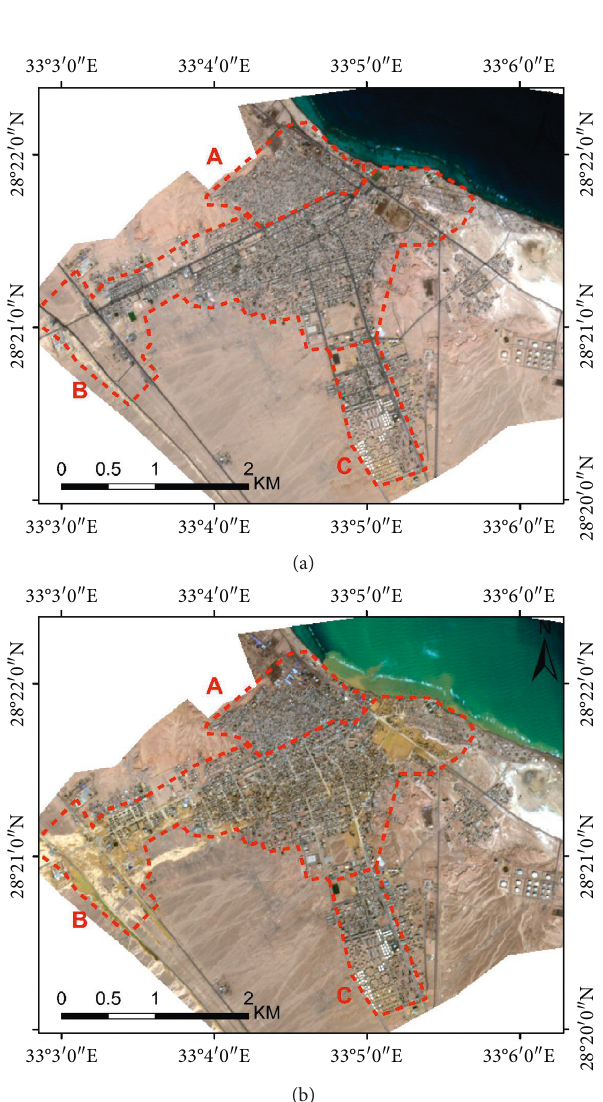
Figure 3: The study area: (a) before flash flood and (b) after flash